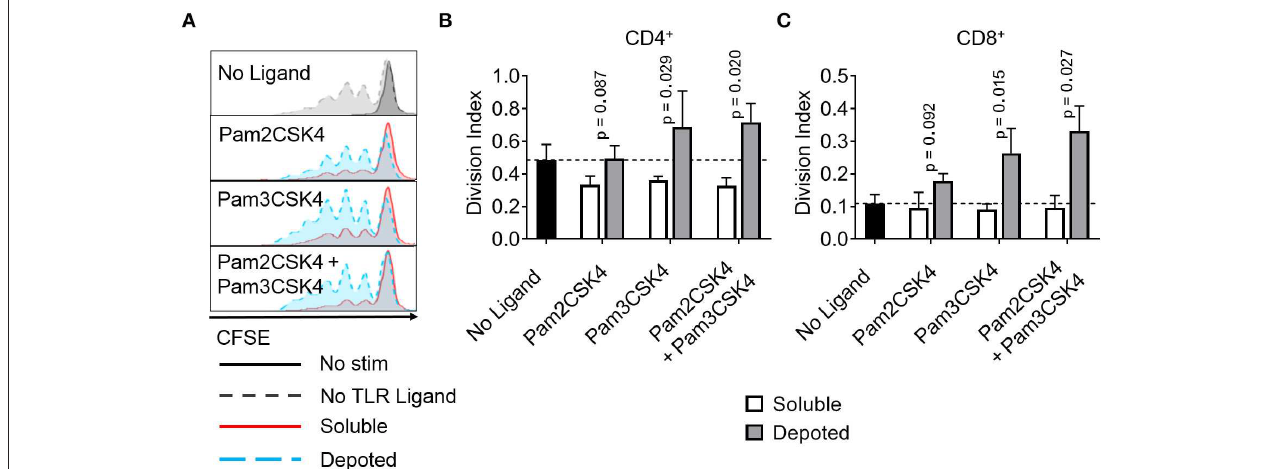
FIGURE 7 | Depoted TLR2 ligands enhance proliferation of activated murine T cells. Purified polyclonal T cells were stained with 5 µ M of carboxyfluorescein succinimidyl ester (CFSE). Different combinations of cell surface ligands (Pam2CSK4 and Pam3CSK4) were either directly added in solution (soluble) or depoted into polyclonal T cells for 1h at 37 ◦ C and cultured with α CD3/CD28 beads for 3 days. (A) Representative histograms of CD4 + T-cell proliferation from delivery of lipid-TLR2 ligand as measured by CFSE dilution. Quantification of division index of (B) CD4 + and (C) CD8 + T cells in bulk polyclonal T cells. Dashed lines represent respective averages (mean) of “No Ligand” conditions. p -values by between soluble vs. depoted ligands as determined by one-tailed ratio paired t -test. Data showed m ± s.d. ( n = 3 independent